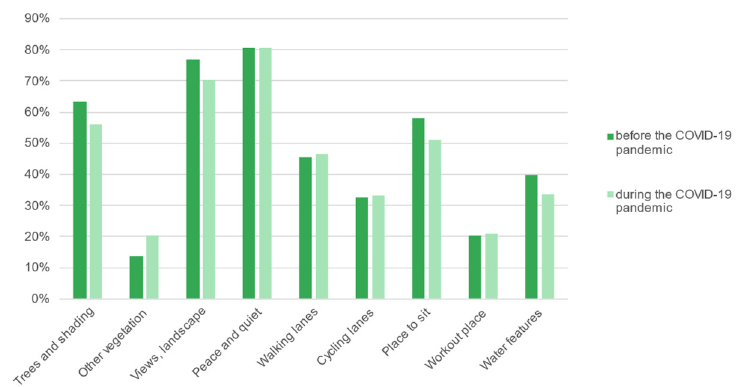
Figure 10. Landscape elements affecting the choice of recreation area before and during the COVID-19 pandemic.